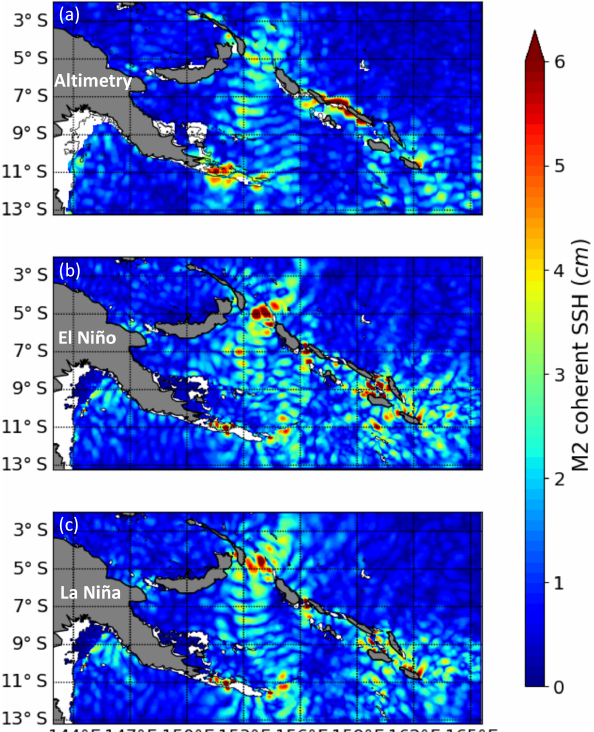
Figure 8. SSH amplitude of the stationary M2 baroclinic tide as es- timated from (a) altimetry by Ray and Zaron (2016), the R36Th simulations during the 3-months of (b) the El Niño period, and (c) the La Niña period. Units in centimeters. Isobathymetric lines are from the NOAA/ETOPO2v2 bathymetric file from the Smith & Sandwell database (https://doi.org/10.7289/V5J1012Q, National Geophysical Data Center, 2006). White color is for bathymetry of less than